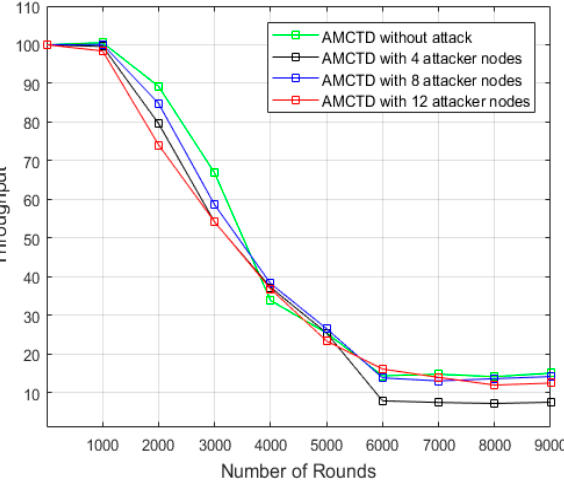
Figure 8. AMCTD: Throughput Analysis without attack and with 4, 8 and 12 Attacker Nodes.